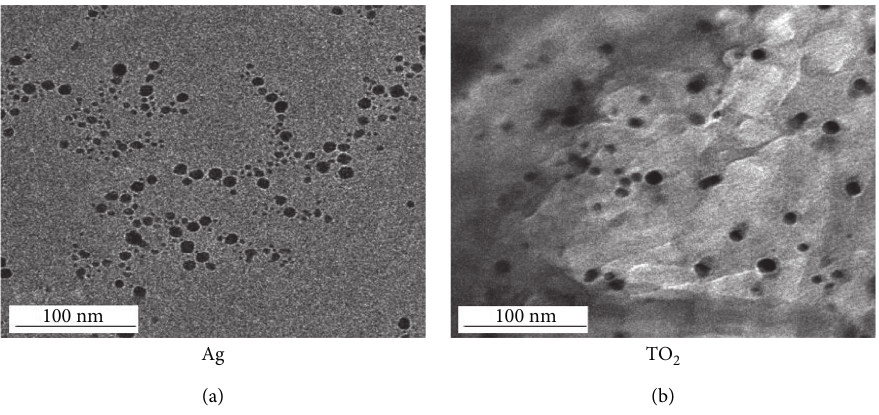
Figure 2: TEM images of nano-TiO 2 and Ag under the best dispersion process (from